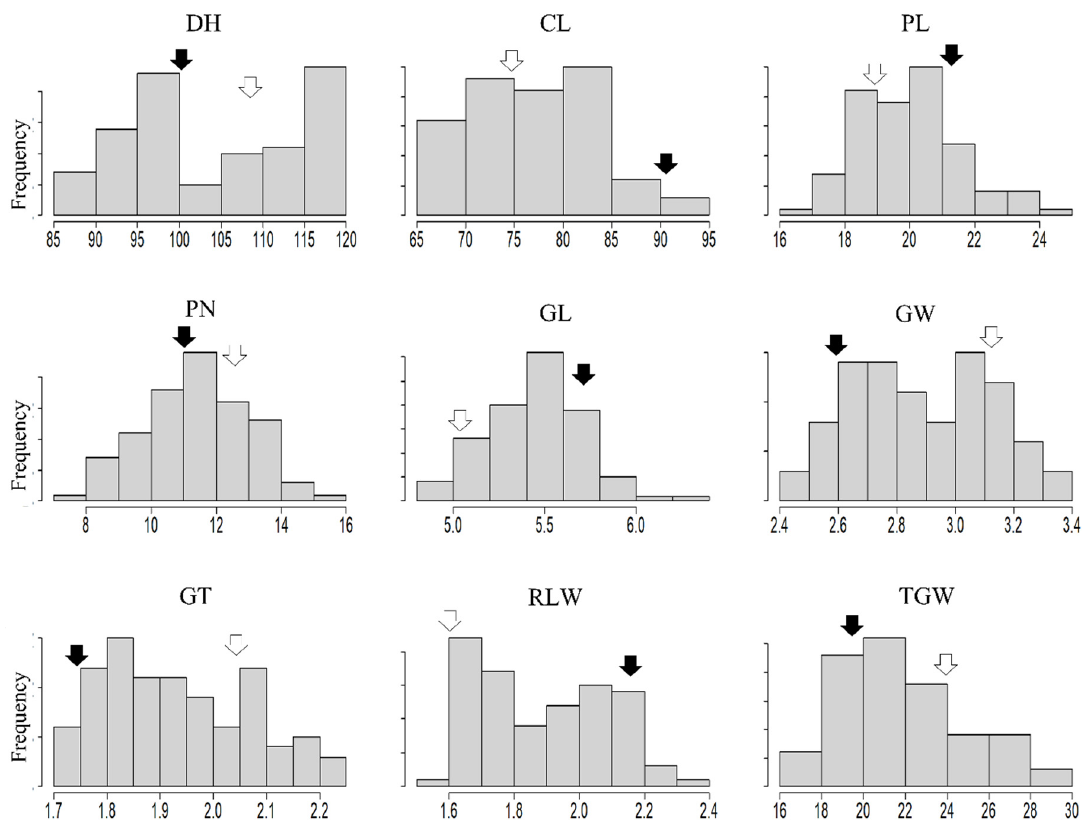
Figure 1. Histograms of the mean values of agronomic traits and traits related to grain shape in the population tested for 2 years. DH, days to heading; CL, culm length; PL, panicle length; PN, panicle number; GL, grain length; GW, grain width; GT, grain thickness; RLW, the ratio of length to width; TGW, 1000 grain weight. The black arrow indicates Pecos, and the white arrow indicates Boramchan.